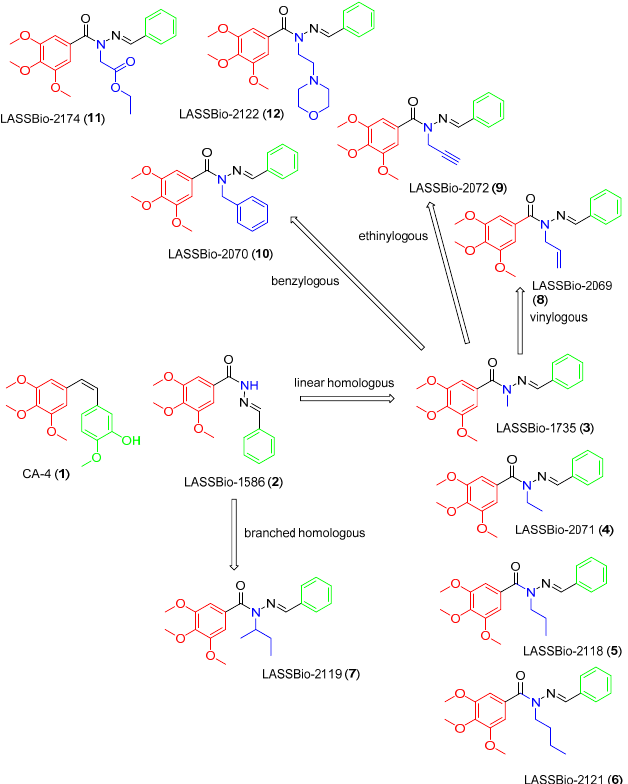
Figure 1. Structures of CA ‐ 4 ( 1 ), LASSBio ‐ 1586 ( 2 ) and compounds 3 – 12 designed using homologation strategy on the nitrogen of N ‐ acylhydrazone framework.